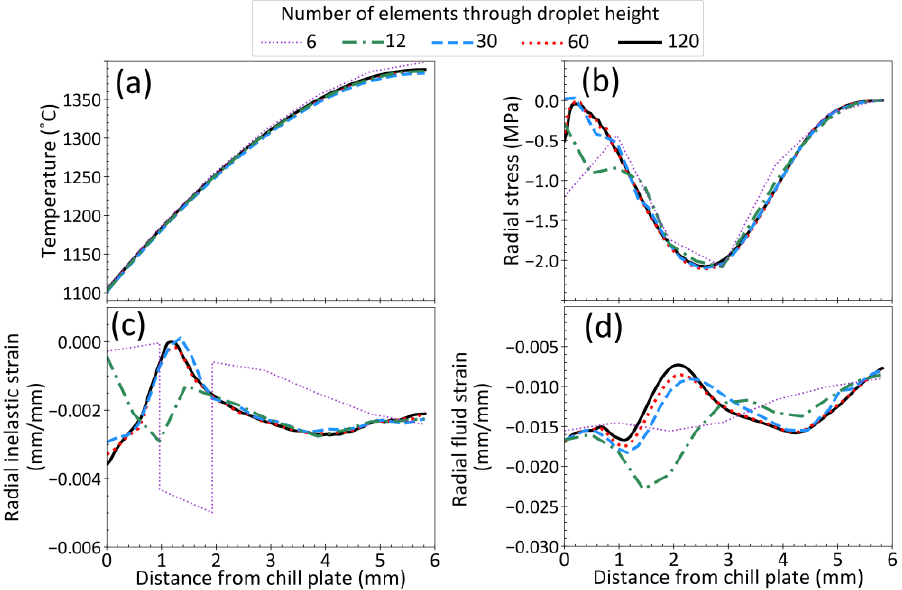
Figure 4. Mesh convergence study results through droplet height at centerline symmetry axis for low-carbon steel (0.05%C) at 5 s with SHF: ( a ) Temperature; ( b ) Radial-stress; ( c ) Radial inelastic strain; ( d ) Radial fluid strain.